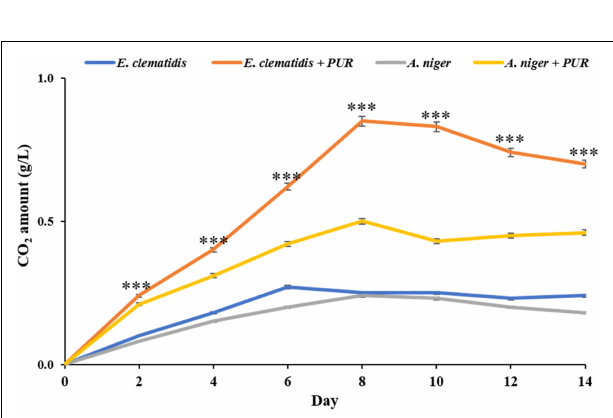
FIGURE 5 | CO 2 amount released by E. clematidis and A. niger in the presence and absence of Impranil as the sole carbon source after 2-week inoculation. ∗∗∗ Above the points indicates a significant difference ( p < 0.001) (ANOVA, followed by Dunnett’s